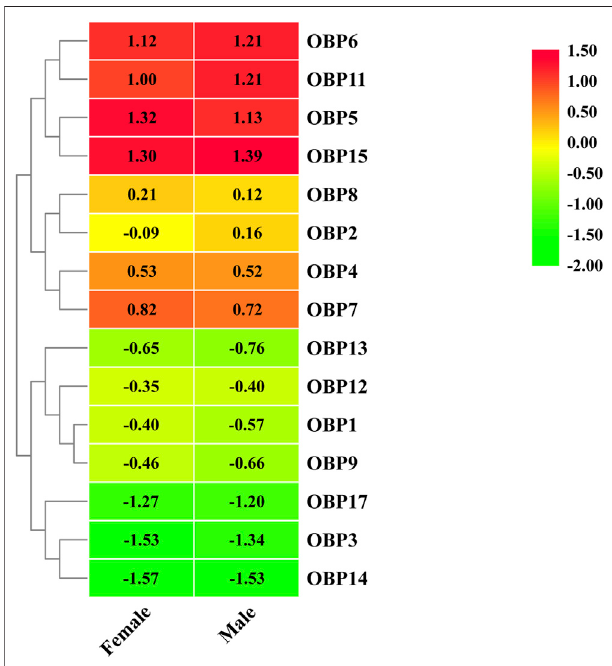
FIGURE 1 | Heatmap of differentially expressed OBP genes between females and males based on FPKM values of antennae transcriptomes.